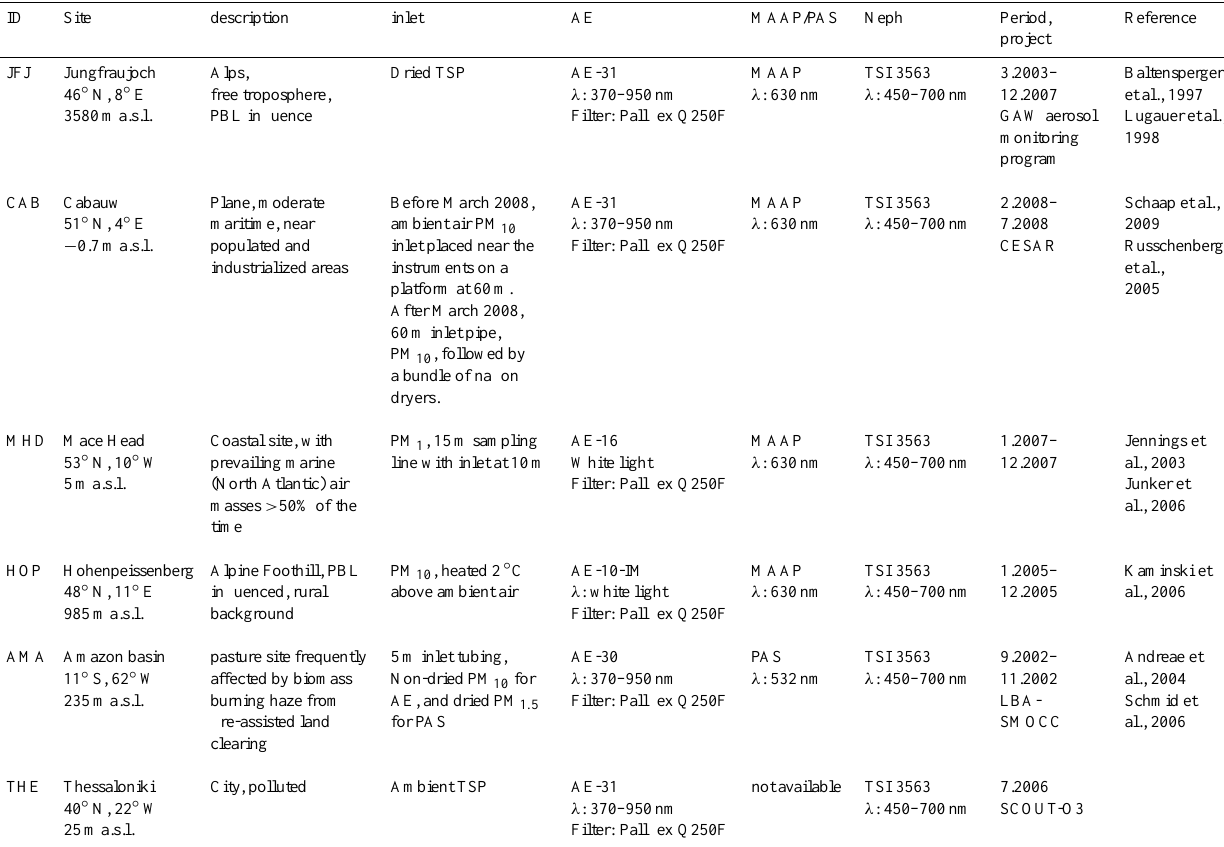
Table 1. Description of the used datasets, including the measuring sites, the instruments, time periods and brief site